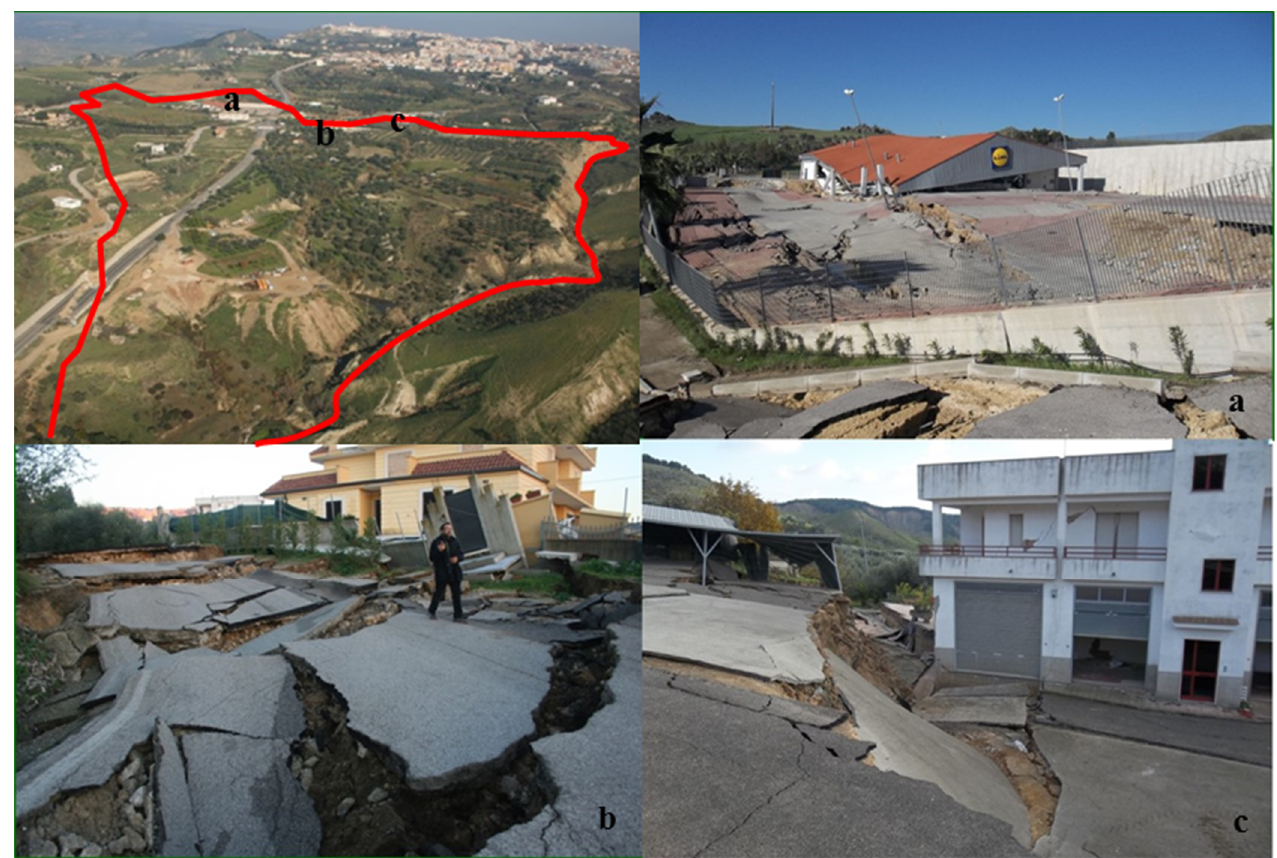
Figure 3. Aerial view of the landslide area and the main effects on buildings. Labels (a, b, c) indicate the location of the pictures in the aerial view.